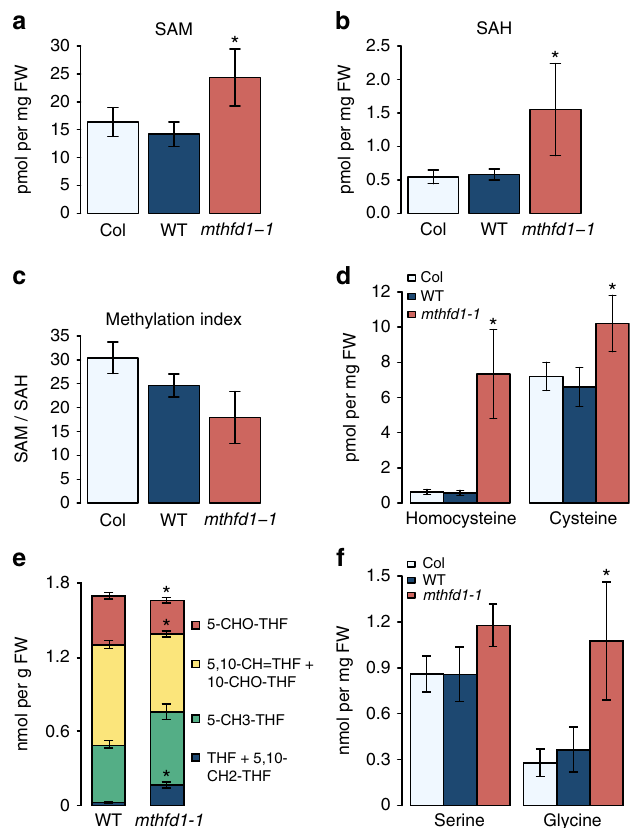
Figure 7 | mthfd1-1 mutants show impaired one-carbon cycle. ( a – f ) Steady-state levels of SAM ( a ), SAH ( b ), Methylation Index (MI) ( c ), selected thiols ( d ), folates ( e ) and selected amino acids ( f ) in leaves of Col, WTand the mthfd1-1 mutant. Data represent means ± SD. Asterisks indicate significant differences determined by Student’s t -test ( P o 0.05, n Z